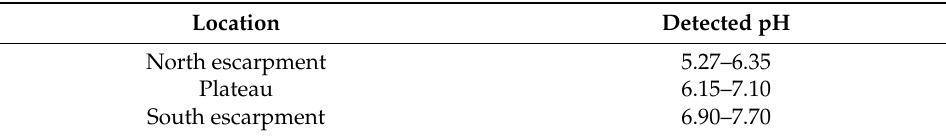
Table 2. Level of pH KCl at Antonia Hill